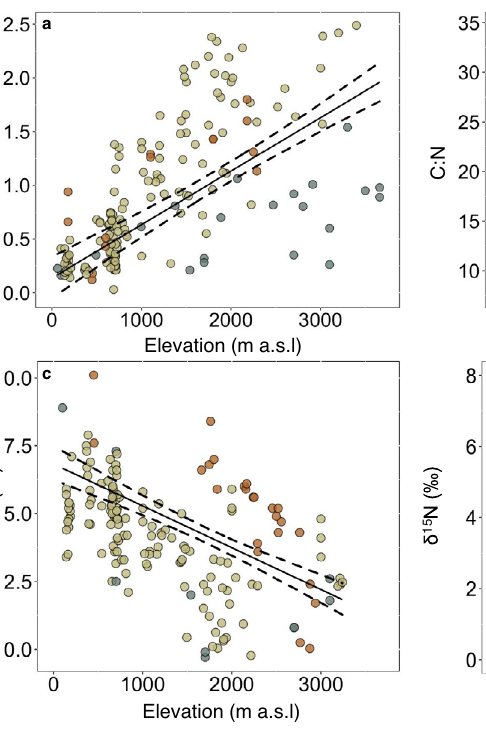
relationshipbetweensoil δ 15 NandNconcentration.Alldatapresentedarefromthe 16 elevational transects. ( a ) lowland n =33, montane n =141, ( b ) lowland n =26, montane n =86, ( c ) lowland n =27, montane n =141 ( d ) lowland n =22, montane n =100.Model95%con fi denceintervals(dashedlines)wereestimatedusingMonte Carlo